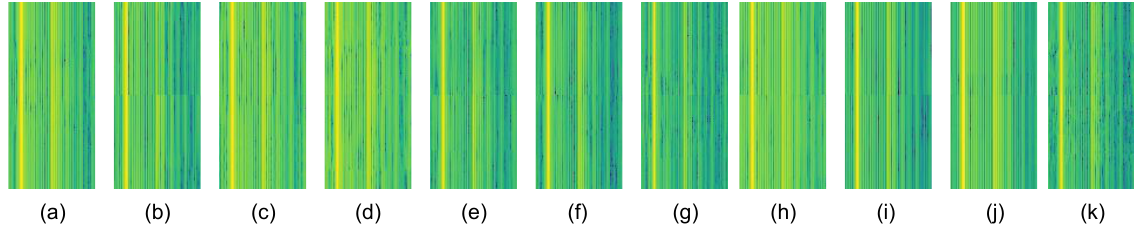
Figure 6. Examples of activity images from 11 classes for the DST transform. ( a ) eat meal/snack; ( b ) falling; ( c ) handshaking; ( d ) hugging other person; ( e ) make a phone call/answer phone; ( f ) playing with phone/tablet; ( g ) reading; ( h ) sitting down; ( i ) standing up; ( j ) typing on a keyboard; ( k ) wear jacket. Figure best viewed in